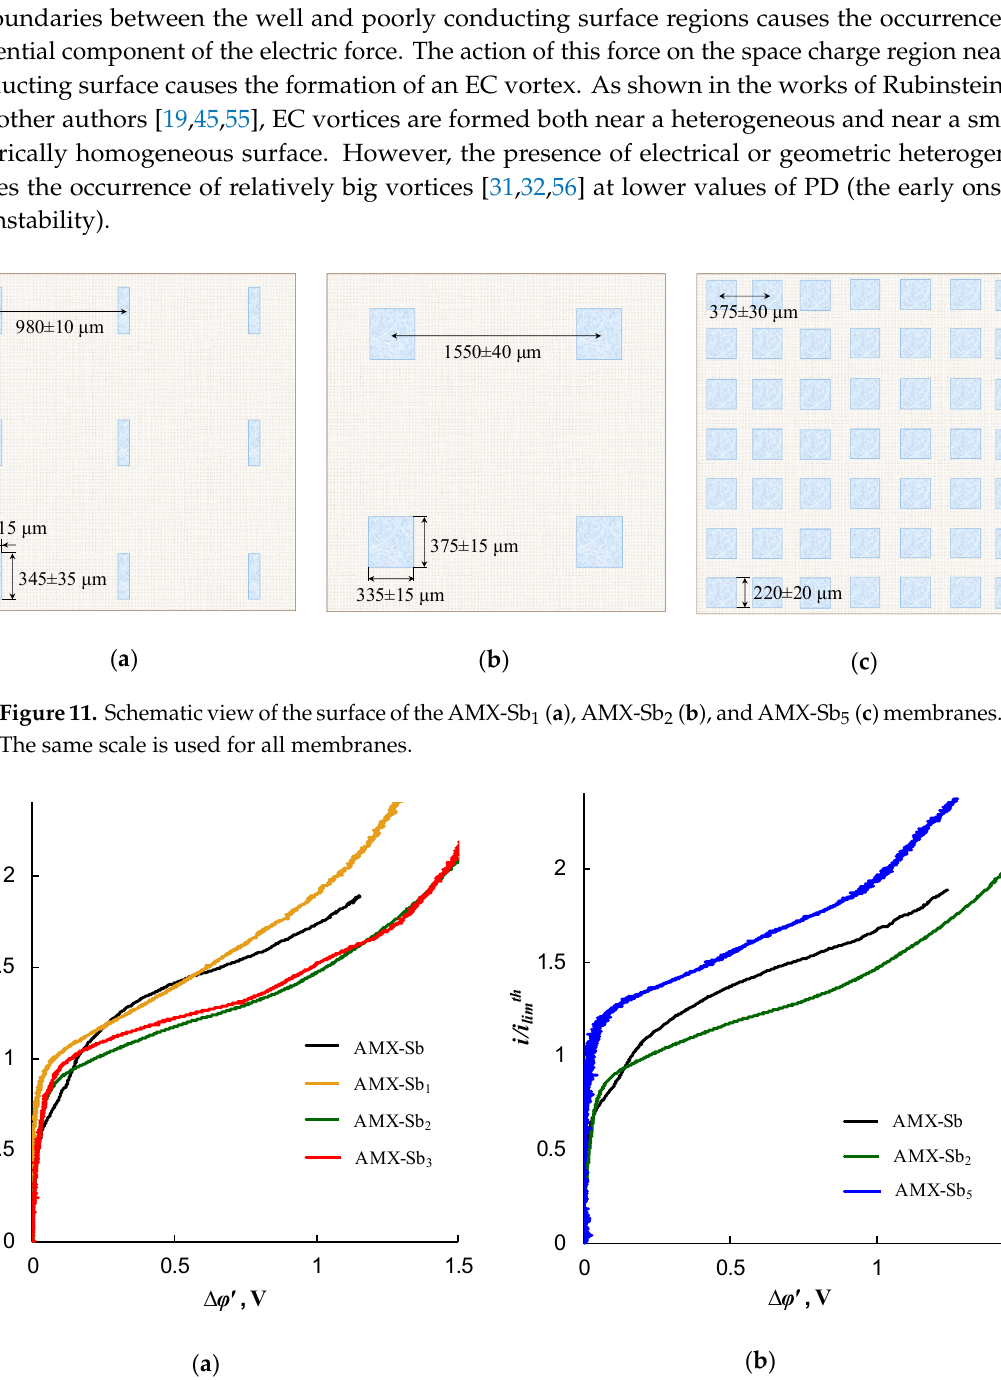
Figure 12. Current–voltage characteristics of the pristine AMX-Sb membrane and di ff erent modified membranes: ( a ) AMX-Sb 1 , AMX-Sb 2 , and AMX-Sb 3 membranes having nearly the same S scr ≈ 10%; ( b ) AMX-Sb 2 and AMX-Sb 5 membranes having nearly the same size of spots and di ff erent values of S scr , for the AMX-Sb 5 membrane S scr ≈ 22%.